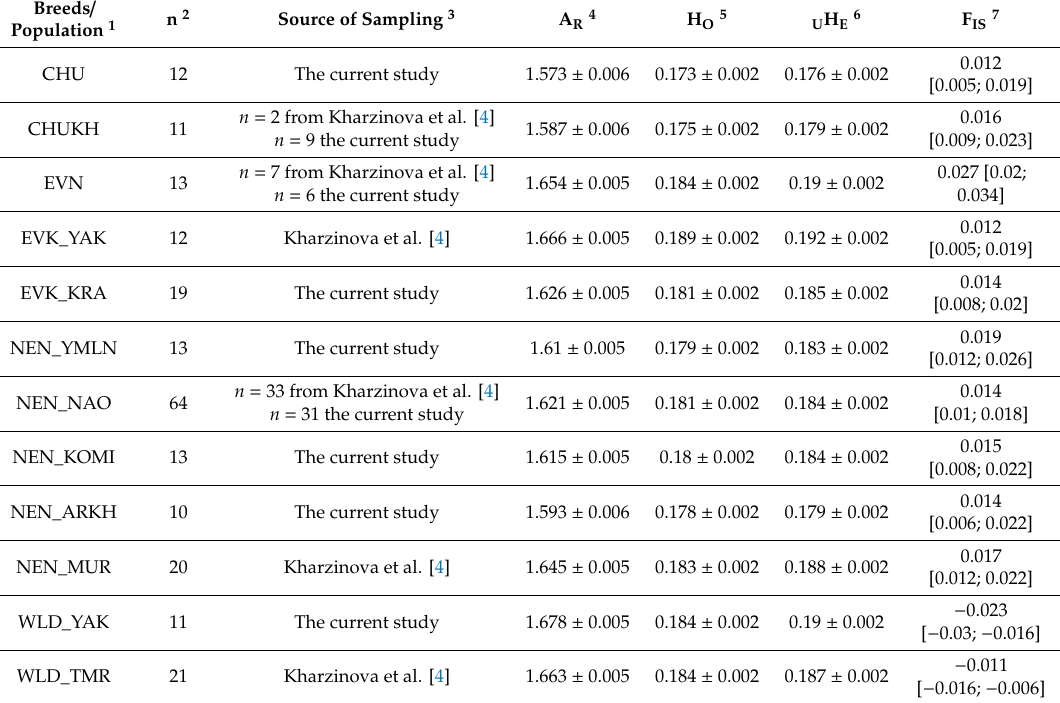
Table 1. Measures of genetic diversity within domestic reindeer